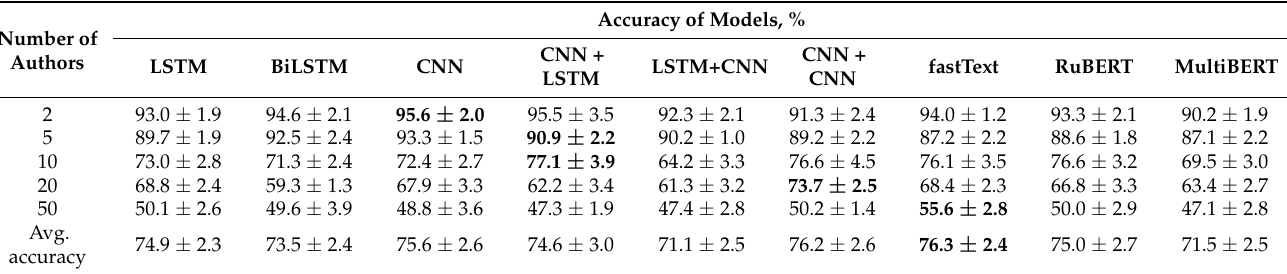
Table 9. Results of author identification using